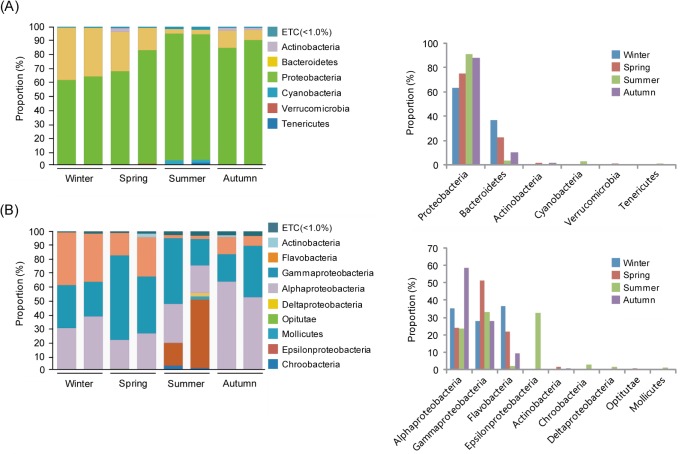
Taxonomic classification of bacterial reads retrieved from pooled DNA amplicons from different seasonal water masses into phylum (A) and class (B) levels using the RDP classifier.